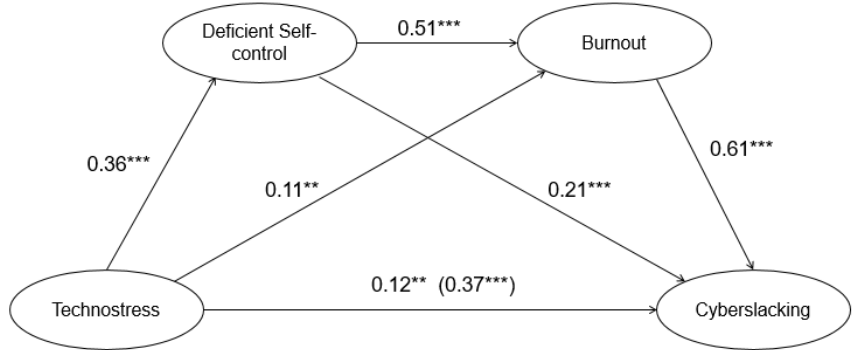
Figure 2. Structural equation model of the influence of technostress, deficient self-control and burnout on cyberslacking. ** p < 0.01; *** p < 0.001.